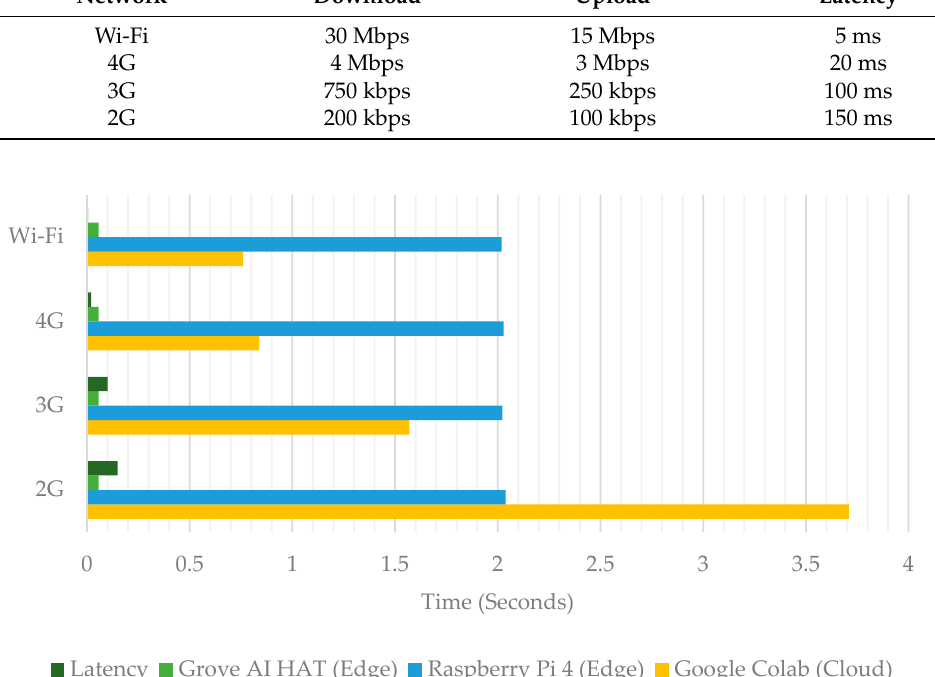
Table 7. Accuracy of the person detector with Grove AI HAT. Grove AI HAT Confusion Matrix Predicted Class Person